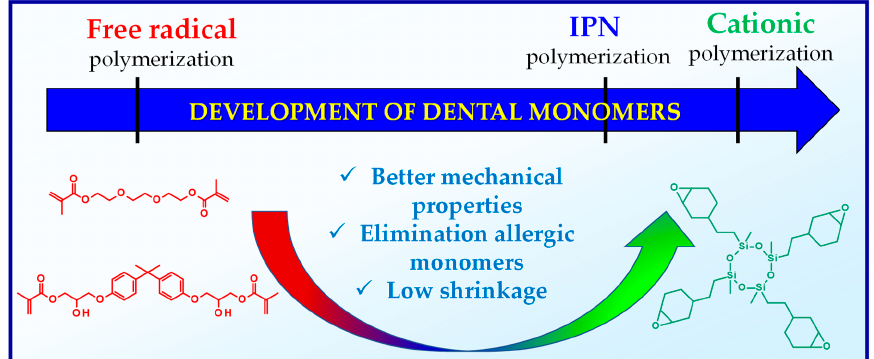
Figure 5. Comparison of the properties of monomers polymerizable via free radical mechanism with monomers polymerizable via cationic mechanism.